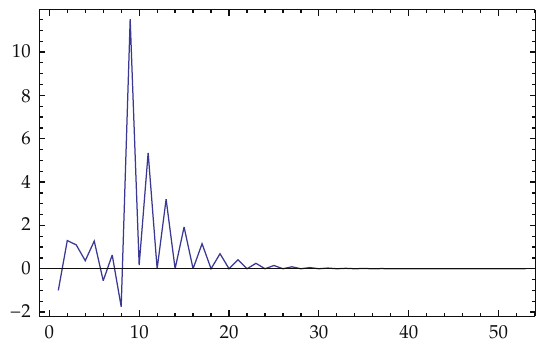
Figure 1: The di ff erence equation y n (cid:3) 1 (cid:4) 0 . 6 y n − 1 / (cid:5) 1 − y n y n − 2 (cid:6) .